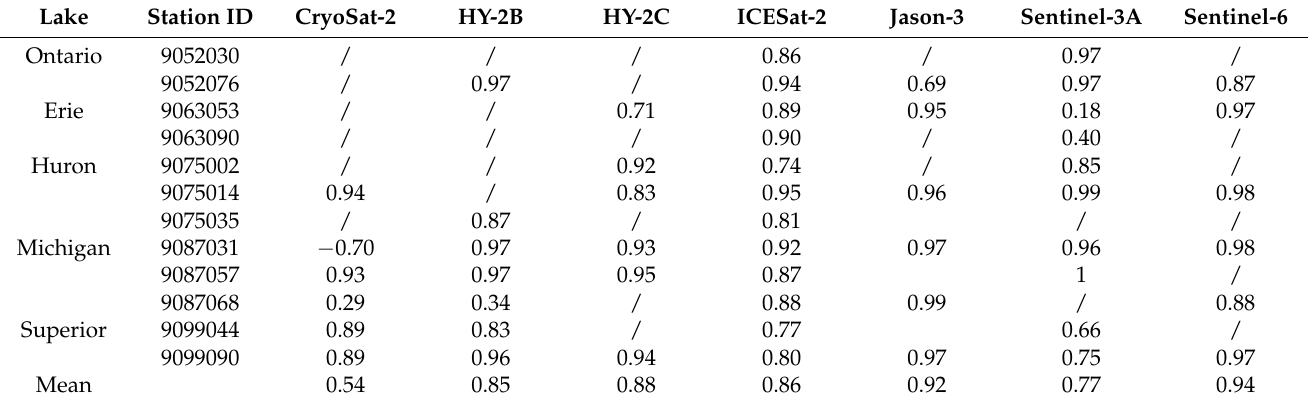
Table 6. Correlation coefficient R of seven altimetry satellites at twelve stations in the Great